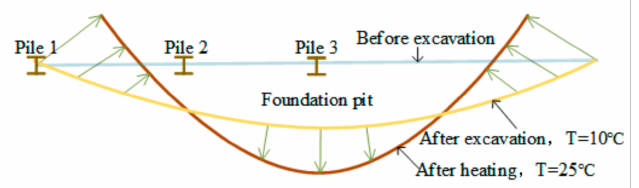
Figure 8. A schematic diagram of the deformation of waist beam